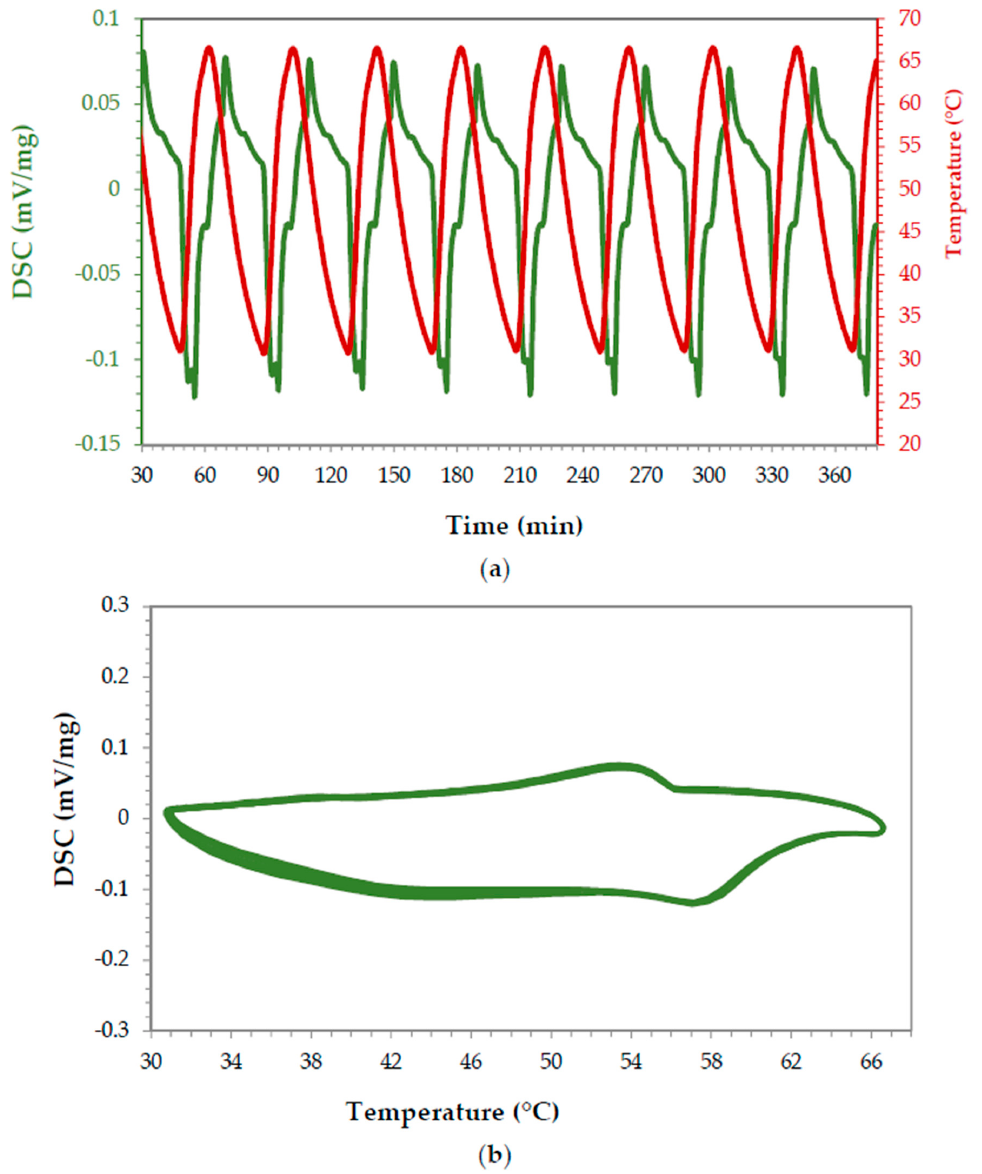
Figure 11. DSC results for sample #3 over 8 cycles: on the ( a ) performance over time, on the ( b ) endothermic and exothermic peaks observed as a function of temperature.